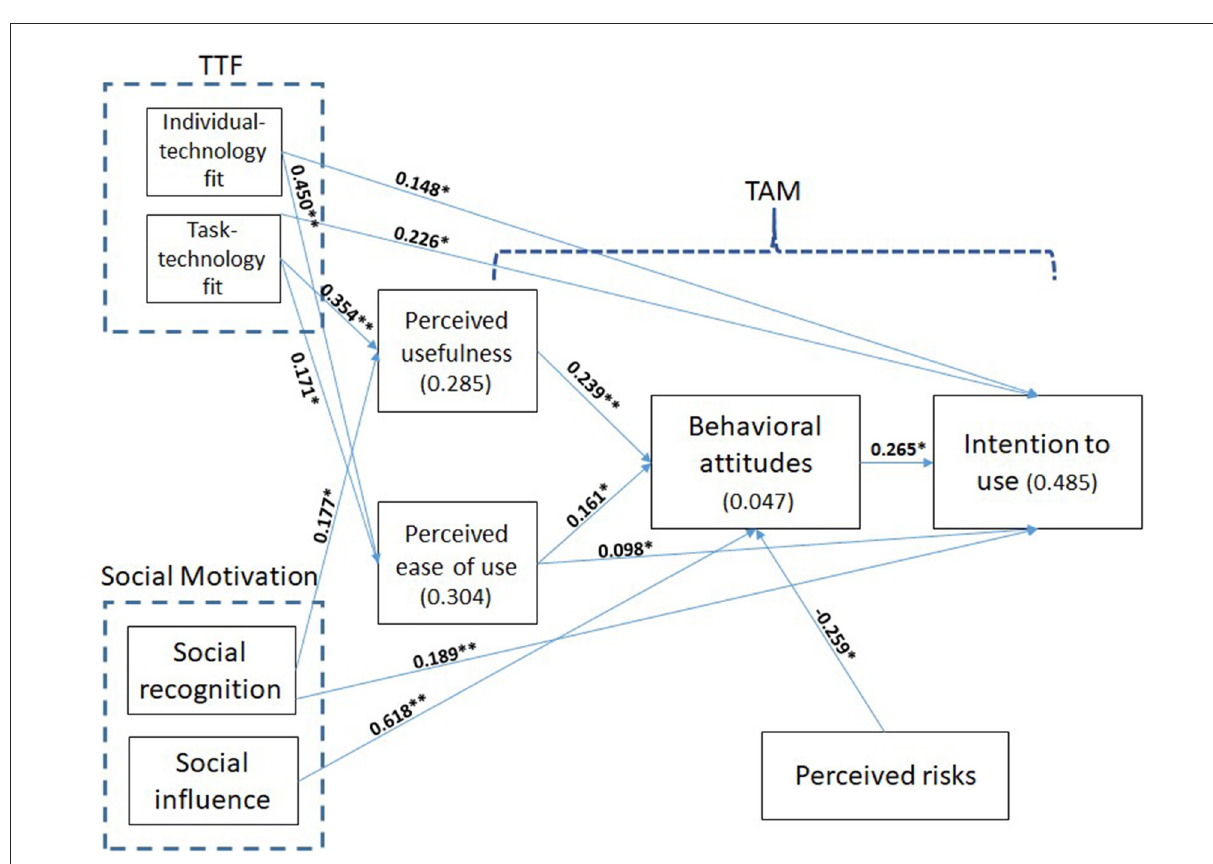
FIGURE2 Path analysis. * p < 0.05; ** p <